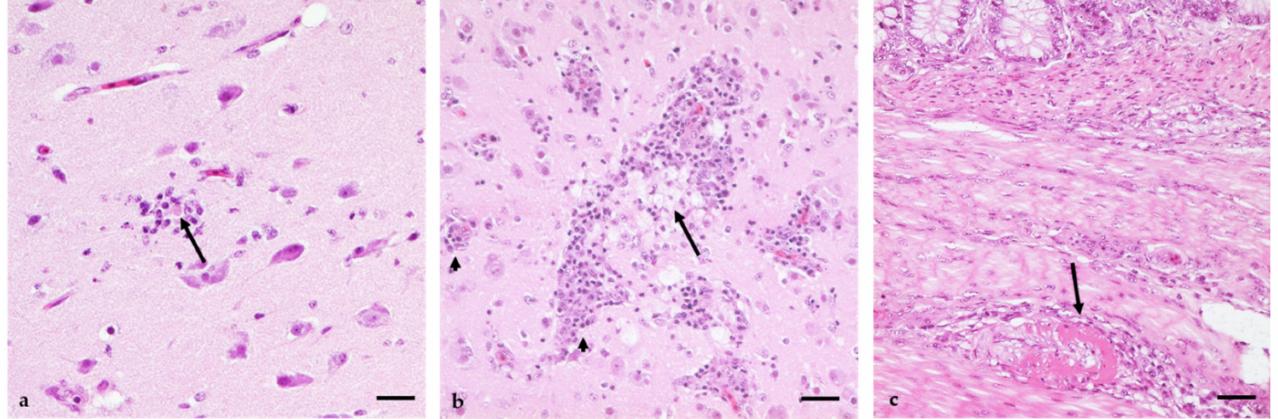
Figure 8. Histomorphological lesions induced by WNV infection in geese. ( a ) Small glial nodule with central neuronal necrosis in brain/cerebrum (arrow), G 5, 10 dpi. ( b ) Multifocal perivascular cuffs (arrowheads) in the brain/cerebrum. Clearly visible are the mild foci of encephalomalacia with gemistocytes clearing the cellular debris (arrow), G 11, 7 dpi. ( c ) Gut with distinct fibrinoid- necrotizing arteritis (arrow) in a medium size vessel of the tunica muscularis, G 11, 7 dpi. H&E, bars = 20 µ